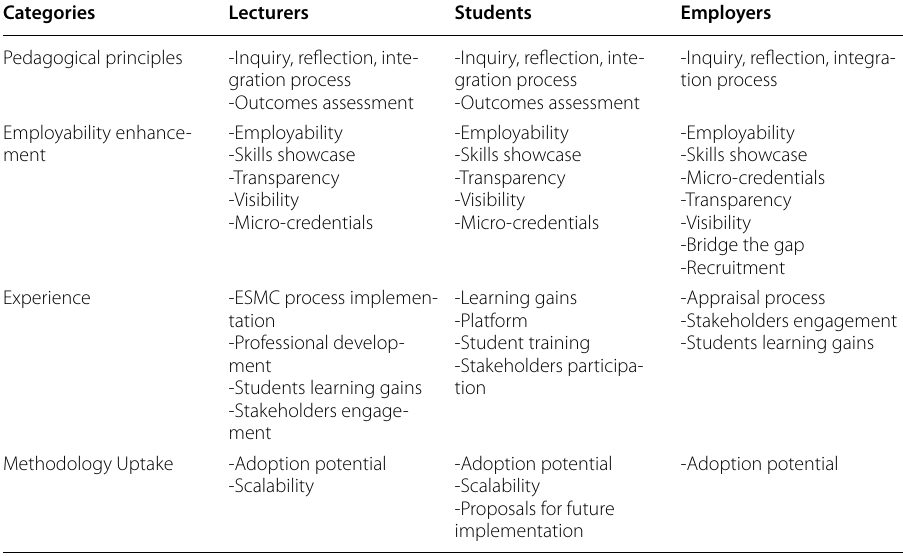
Codes and categories